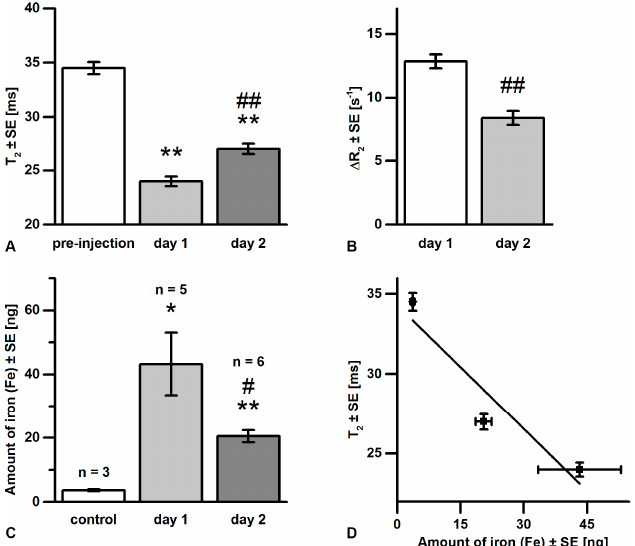
Figure 7. Bar graphs representing mean values ± standard error (SE). ( A ) Mean T 2 values of plaque ROI at three time points ( n = 27). ( B ) Average ∆ R 2 values of plaque ROI at day 1 and 2 ( n = 27). ( C ) Mean amount of iron (Fe) in the aortic arch determined by pEPR for three groups sacrificed at different time points. Significant differences with pre-injection or control values are marked with * ( p < 0.05) or ** ( p < 0.001). Significant differences with day 1 values are marked with # ( p < 0.05) or ## ( p < 0.001). ( D ) Mean R 2 values versus iron content. The solid line represents a linear fit ( R 2 = 0.86).